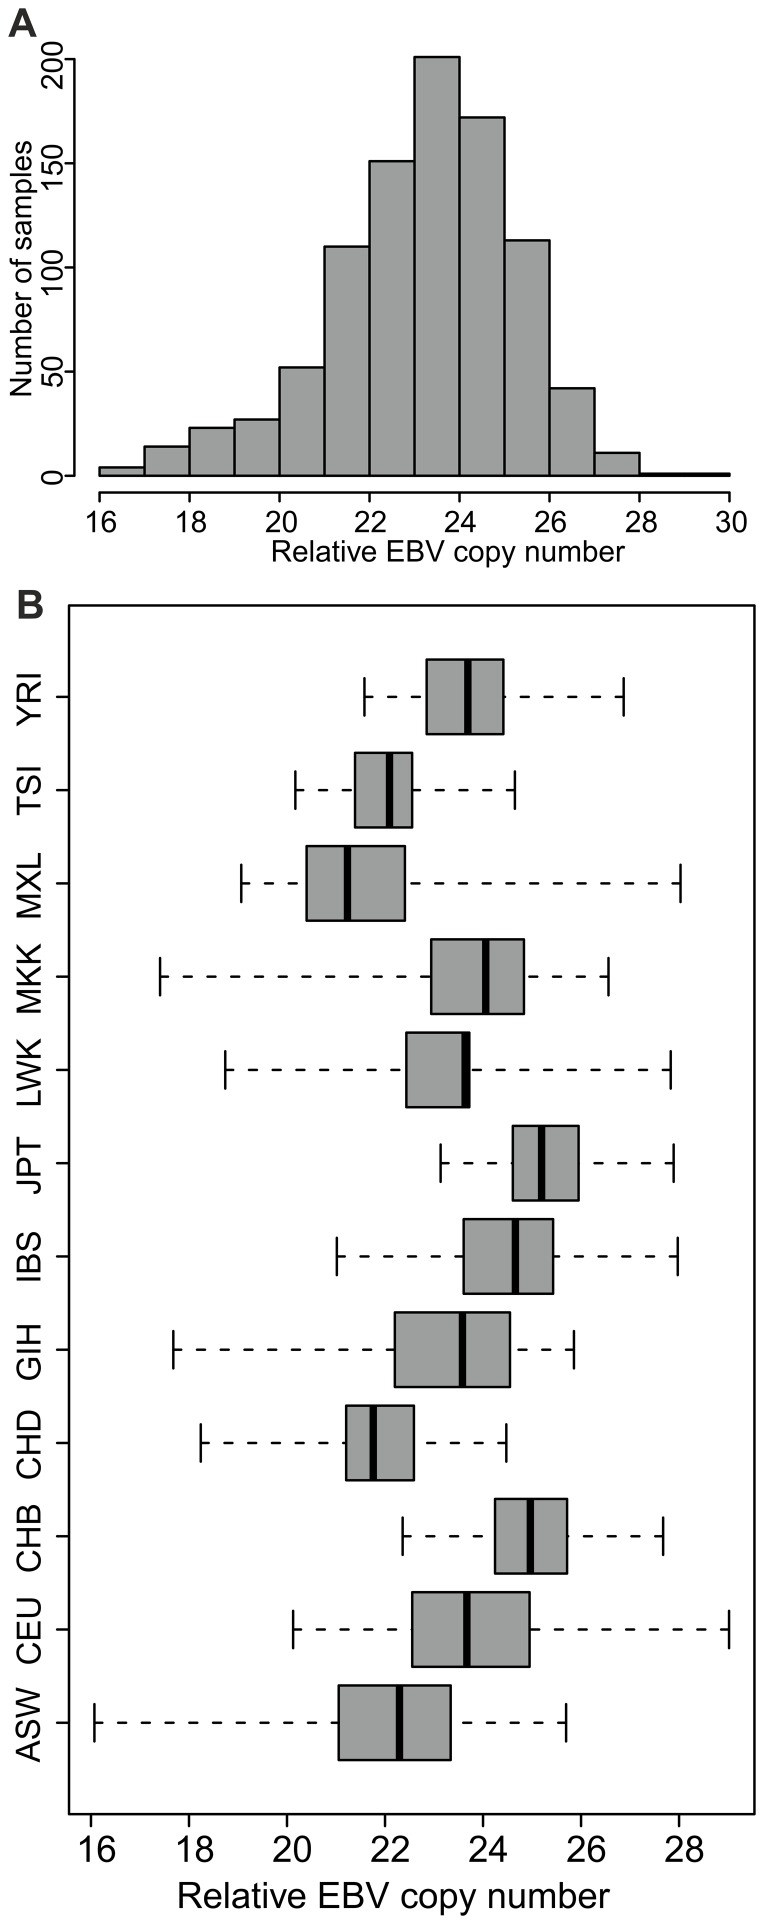
Distribution of relative EBV copy number in LCLs from 12 populations.
A. Relative EBV copy number in 915 LCLs from 12 populations, including 97 parent-offspring trios. Range 16.07–29.02, mean 23.36 (SD±2.03). The data are not normally distributed (Shapiro-Wilk: W = 0.977, p-value  = 2.086−11). B. Box and whisker plots showing the range (dotted lines), interquartile range (coloured boxes) and mean relative EBV copy number (central vertical lines) for the 12 populations included in this analysis.